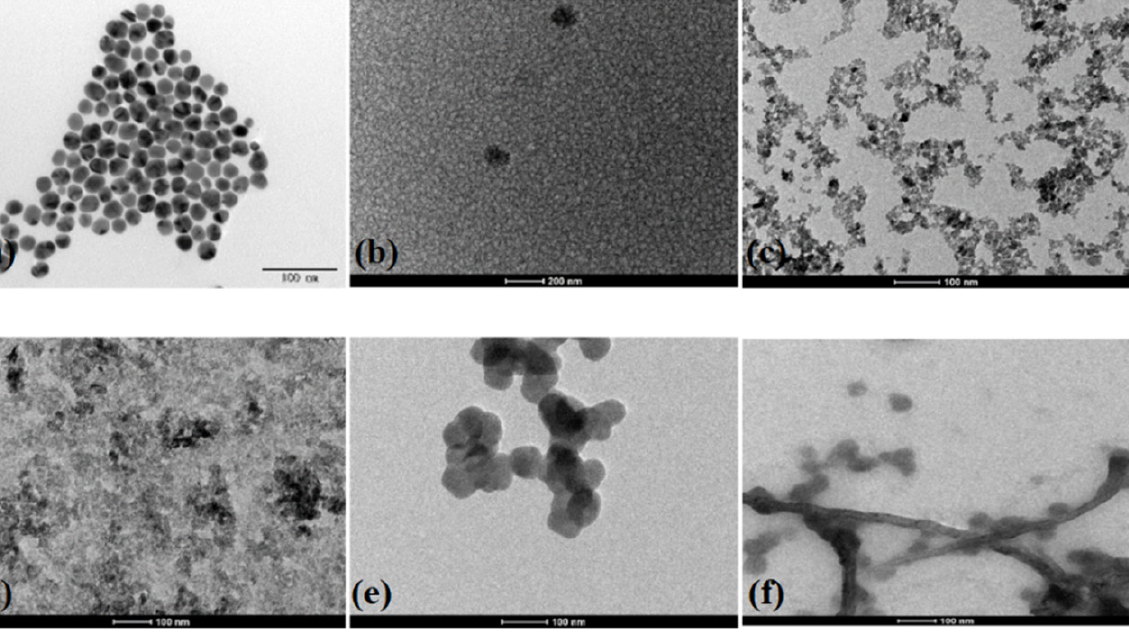
Figure 3. TEM images of six nanofluids ( a ) Ag ( b ) Au ( c ) TiO 2 ( d ) Al 2 O 3 ( e ) CuO ( f ) MWCNT. 2.3. Preparation and Characterization of Hybrid Nanofluids